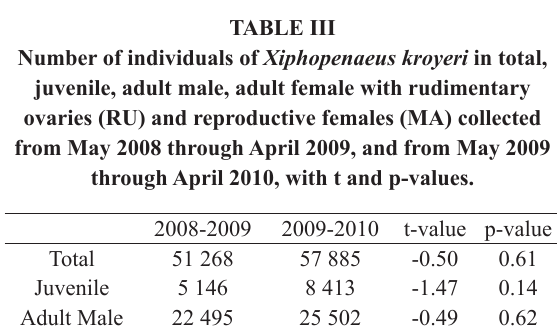
Fig. 3 - The mean, standard deviation, maximum and minimum values of (A) salinity and (B) temperature (°C) in the sample locations in the São Vicente Estuary (1-4) and in the Santos Bay (5-8), São Paulo, Brazil, from May 2008 through April 2010.